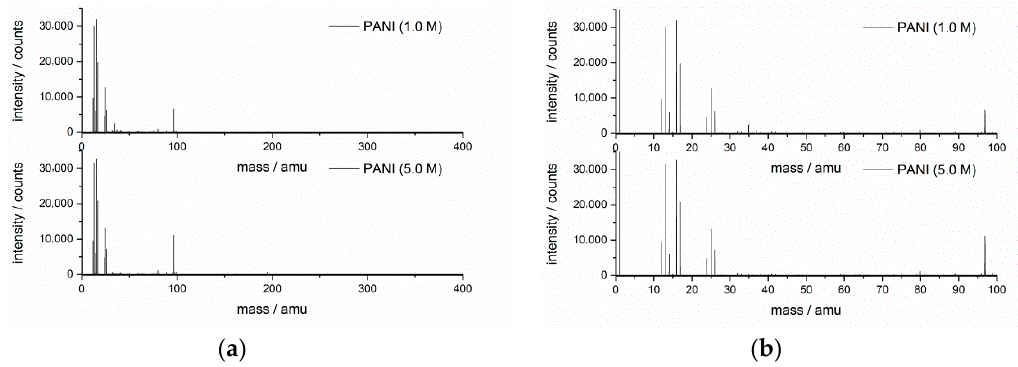
Figure 7. Time-of-flight secondary ion mass spectrometry (TOF-SIMS) mass spectra of doped PANI (1.0 M) and PANI (5.0 M) in positive polarity of the mass analyzer: ( a ) 0–400 amu range; ( b ) 0–100 amu range.